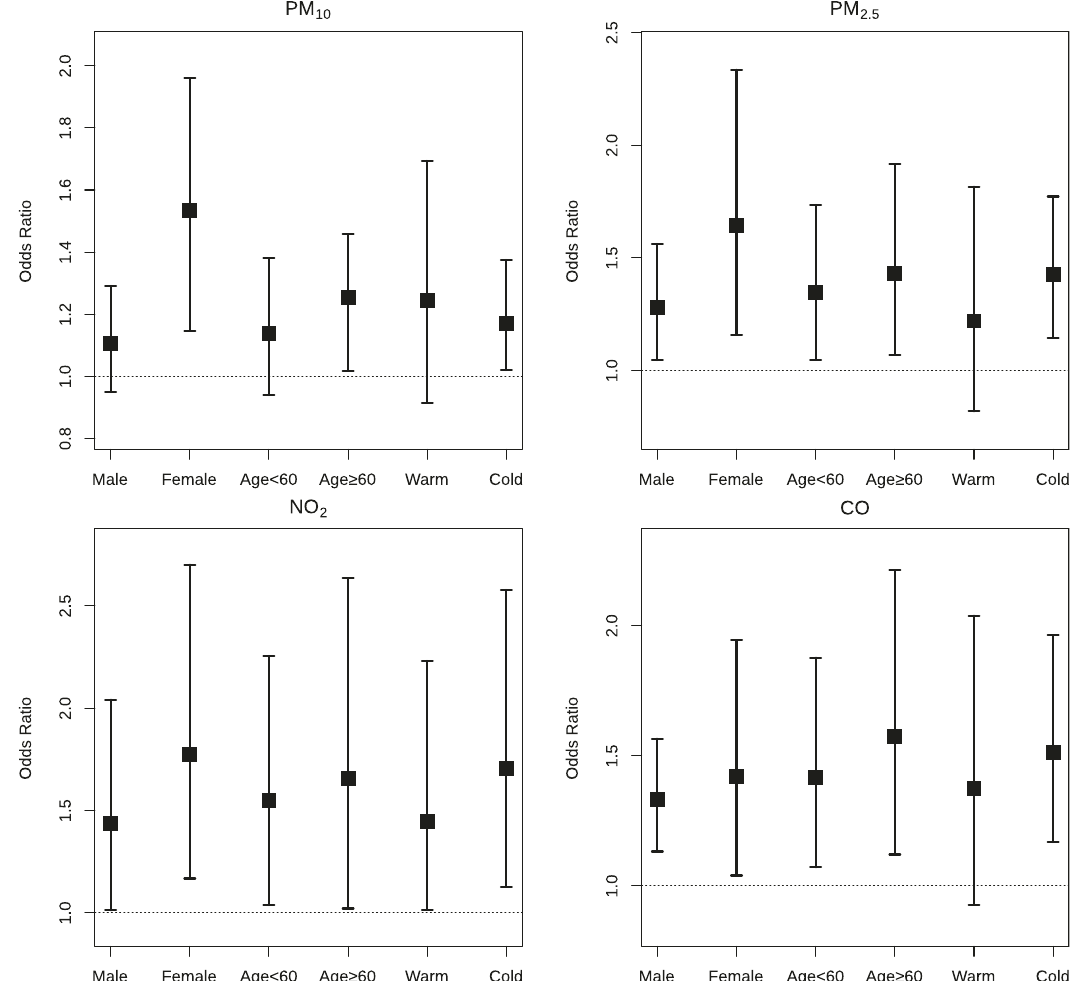
Fig. 3 Odds ratios of atrial fi brillation associated with an interquartile range increase in air pollutant concentrations at lag 18 – 24 h, strati fi ed by gender, age, and season. Abbreviations and interquartile range concentrations as in Table 2. Warm season, April to September; Cold season, October to March. Error bars are de fi ned as standard deviation (s.d.). Table 2. Associations between air pollutants and atrial fi brillation in single- and two-pollutant models.